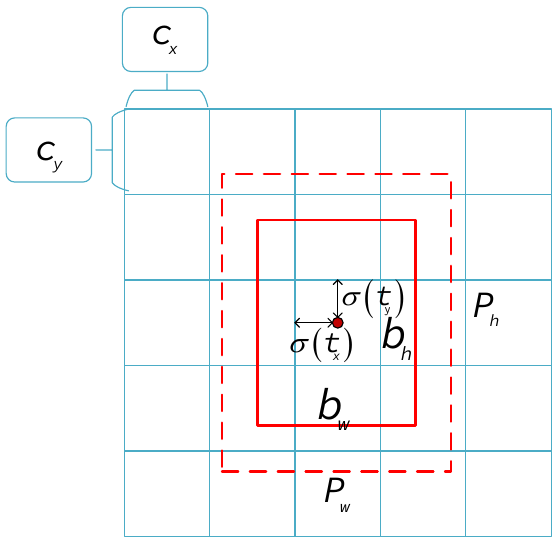
Figure 2. The final bounding box prediction schematic. In Formulas (2) and (3), b x and b y are the coordinates of the center point of the modified bounding box; b w and b h represent the width and height of the modified bounding box, respectively; t x and t y represent the offset between the object center point and the upper-left corner of the grid; t w and t h represent the offset of the width and height of the predicted bounding box, respectively; c x and c y represent the offset of the grid relative to the upper-left corner. p w and p h are the width and height of the prior box, respectively. The sigmoid function is used to control the range of value within (0, 1) and control the offset of the object center within the corresponding grid cell to ensure that it is not out of